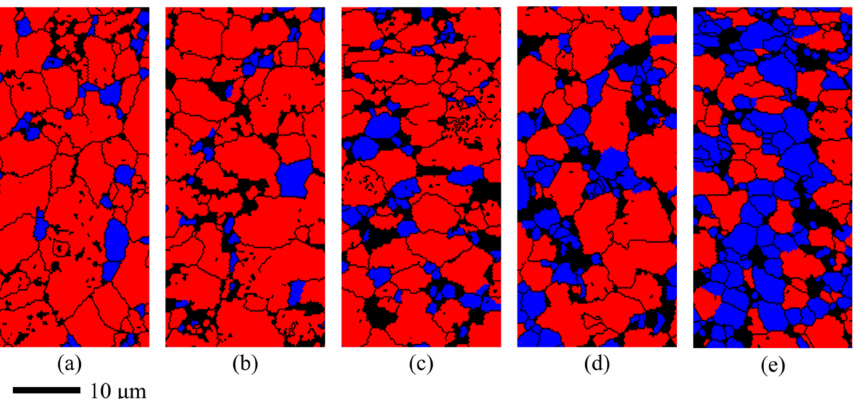
Figure 10. The distributions of recrystallization at different strains when deformed at 950 ◦ C and 0.01 s − 1 : ( a ) Initial; ( b ) 0; ( c ) 0.1; ( d ) 0.5; ( e ) 0.9 (blue represents the recrystallized grains, red represents the deformed grains).